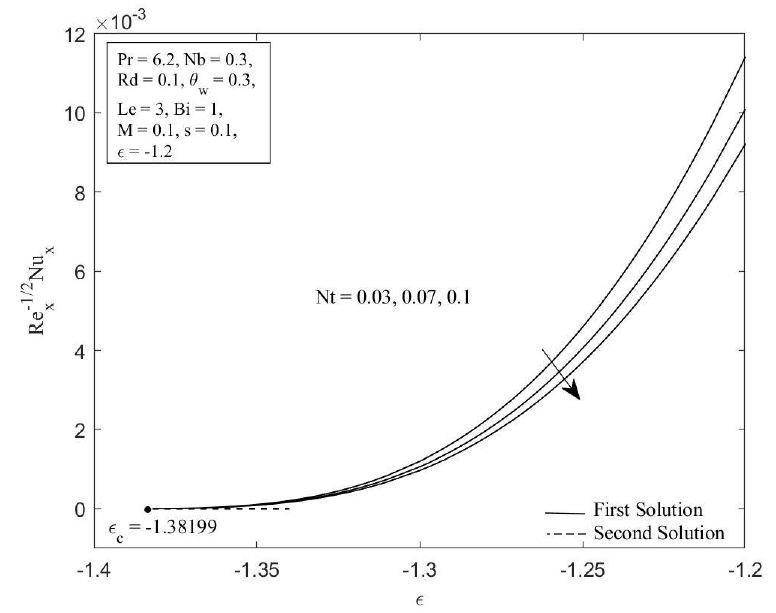
Figure 4. Local Nusselt number 𝑁𝑢 𝑥 𝑅𝑒 𝑥−1 2⁄ against 𝜀 for diverse values of 𝑁𝑡 .